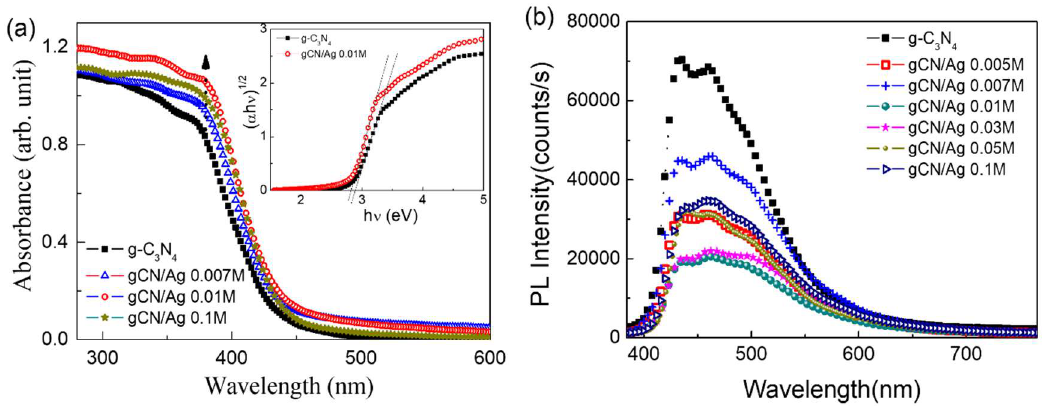
Figure 4. ( a ) UV-vis diffuse reflectance and ( b ) photoluminescence (PL) spectra of as-synthesized samples with different Ag + concentrations.